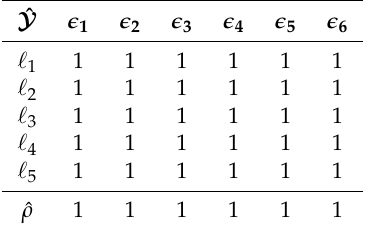
Table 8. Level soft set L ( ˆ Γ ; bt